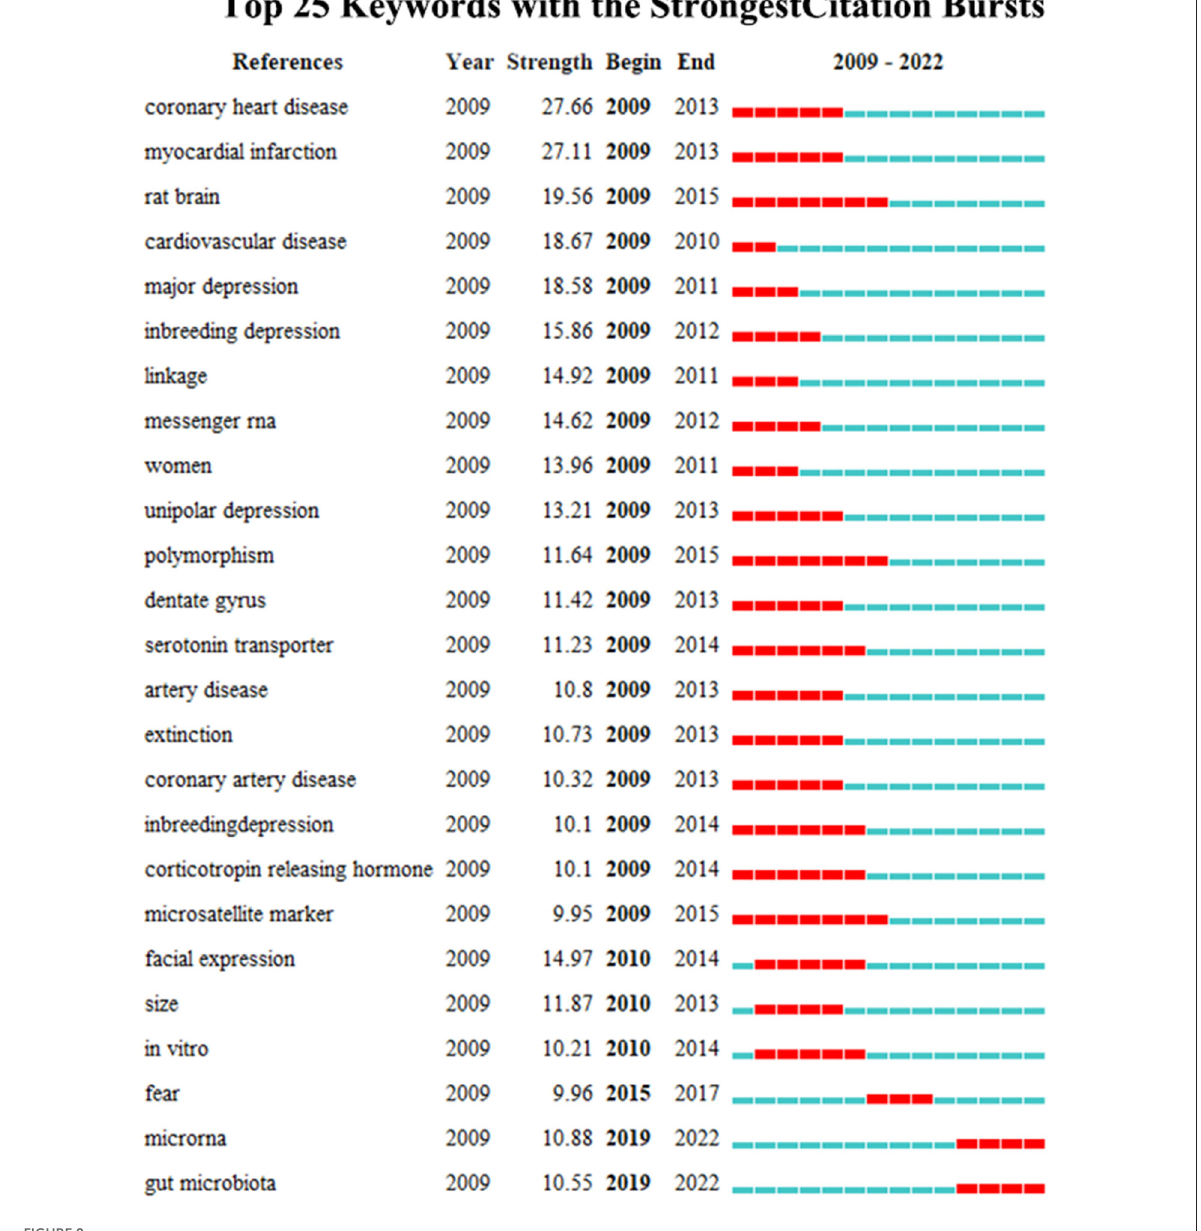
FIGURE8 Top 25 keywords with the strongest citation bursts,